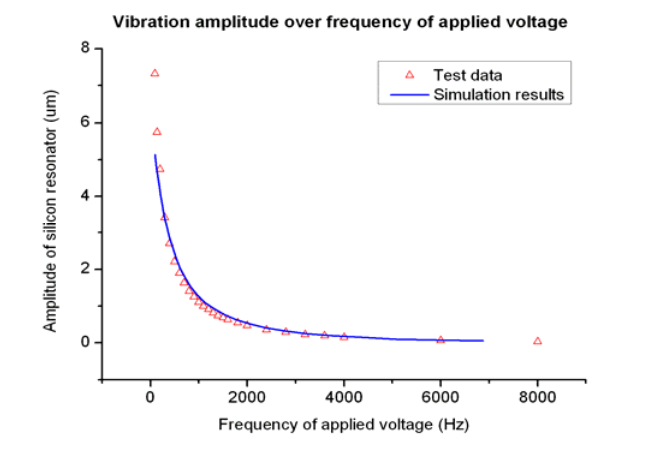
Figure 15. Vibration amplitude of the magnetometer over voltage